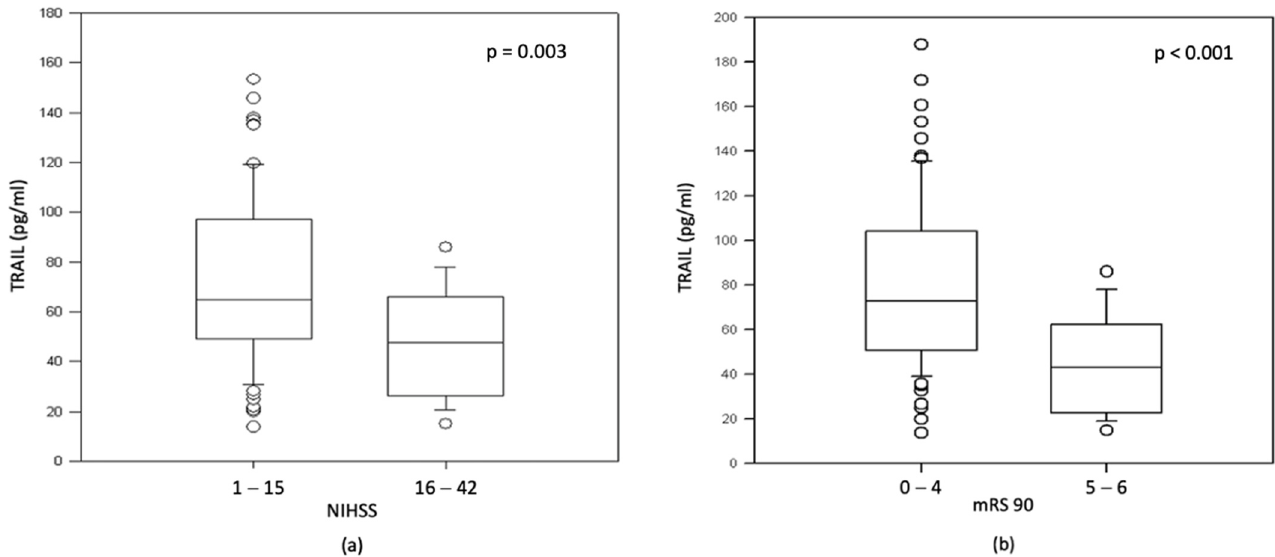
Figure 2. Association between TRAIL levels on day 1 and NIHSS score and mRS at 90 days in patients after AIS. ( a ) Association between TRAIL level and NIHSS score; ( b ) association between TRAIL level and mRS at 90 days.